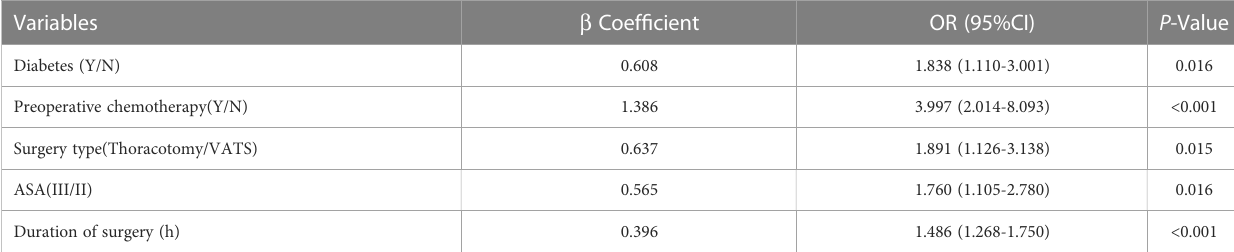
TABLE 3 Multivariate Logistic Regression Analysis of POP Based on Data in the Training Cohort.